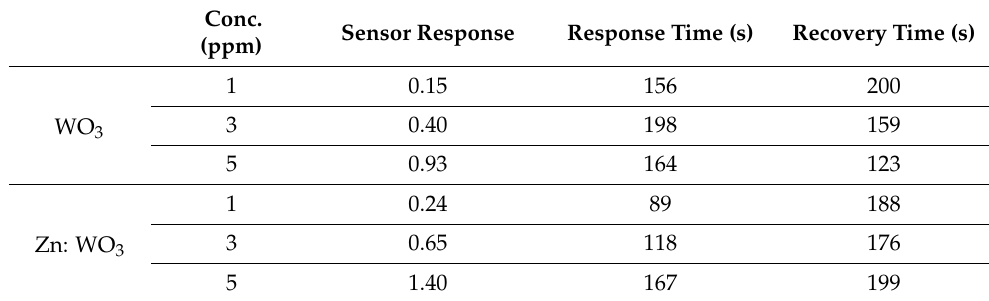
Table 2. Sensing parameters of WO 3 and Zn: WO 3